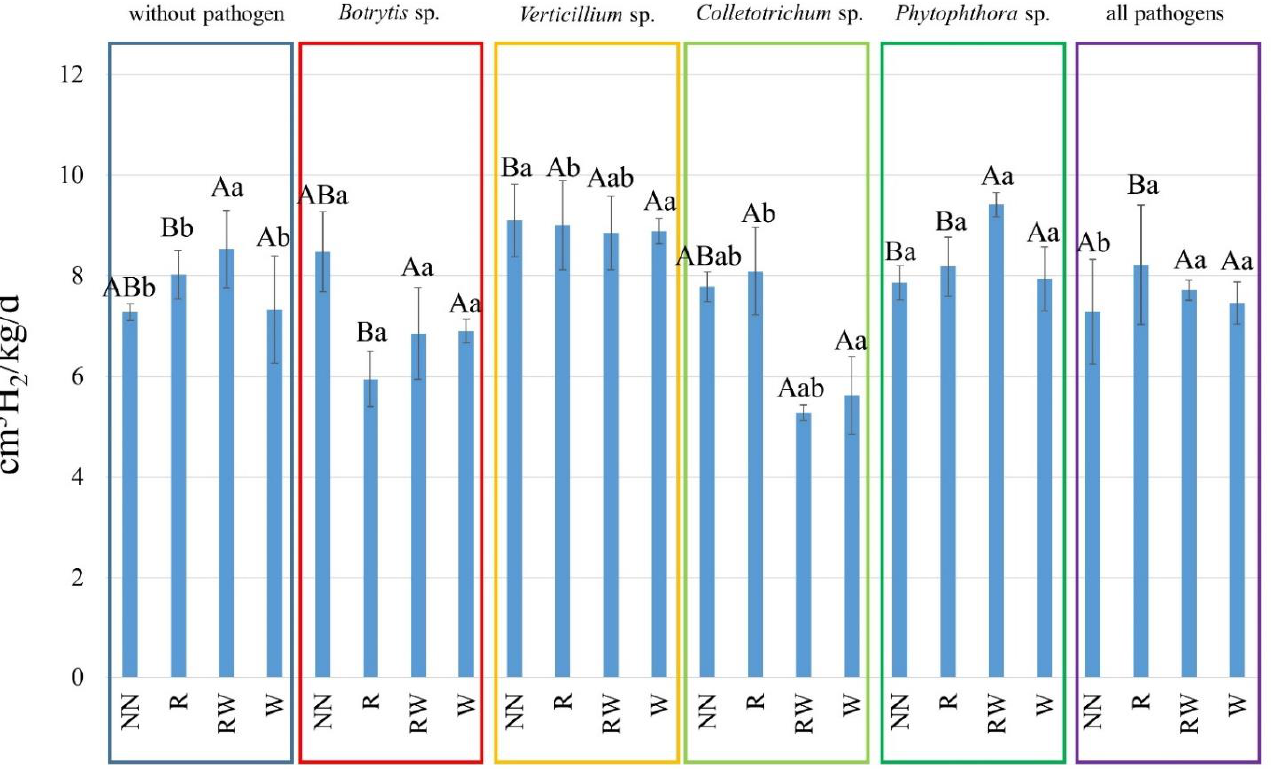
Figure 5. The effect of the bacterial consortium on dehydrogenase activity in the soil samples depending on the pathosystem and naturalization strategy applied. Dehydrogenase activity varied according to the pathosystems used, Botrytis cinerea , Verticillium sp., Colletotrichum acutatum , Phytophthora sp., and all pathogens ( Botrytis , Verticillium , Colletotrichum , Phytophthora ) and without pathogens, within different biopreparation application strategies: no naturalization (NN), root inoculations (R), root inoculations and watering (RW), and watering (W). Error bars indicate the standard deviation, n = 3, different lowercase letters above the bars indicate differences within the particular pathosystem, and different capital letters above the bars indicate differences within the particular naturalization strategies (according to ANOVA with p < 0.05).